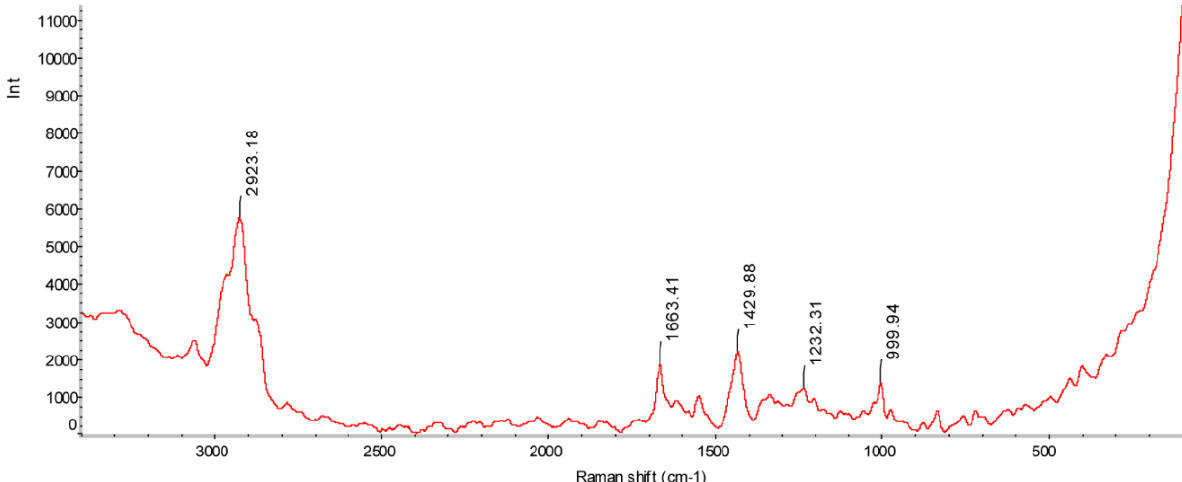
Figure 2. Raman spectroscopy of KN-17.